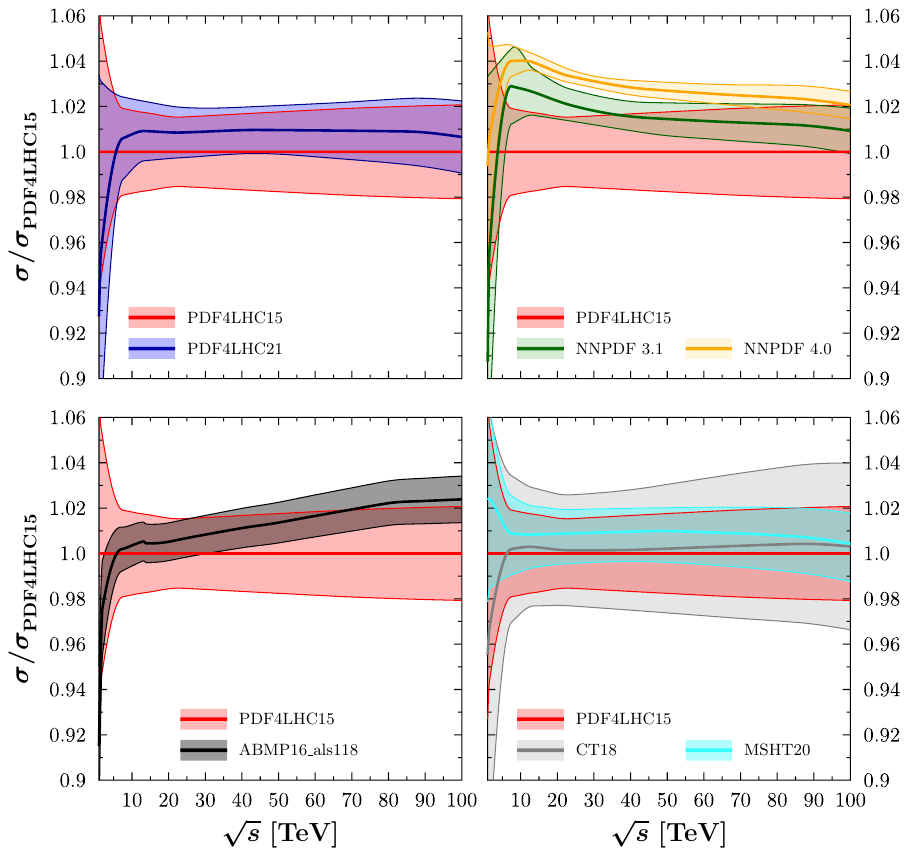
Figure 19 . Same as in figure 17, but for ZH inclusive cross